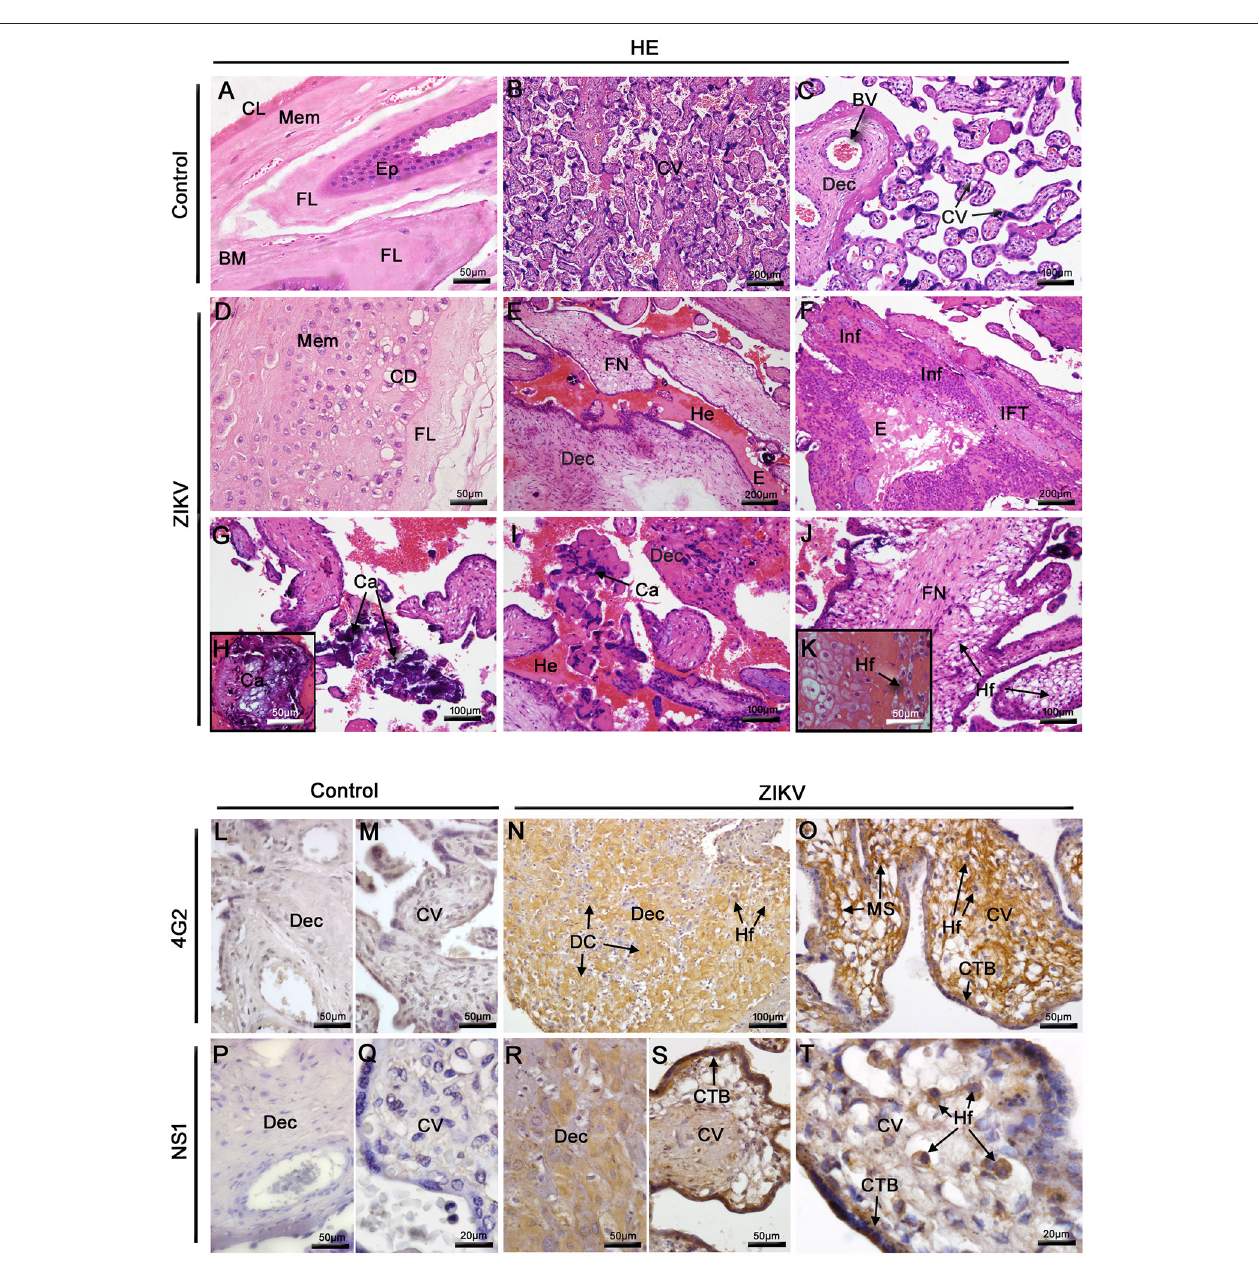
FIGURE 1 | Histopathological analysis of the placenta and detection of ZIKV. (A–C) Placenta of a non-ZIKV patient stained with H.E. and presenting normal features: membrane (Mem), (MB) basal membrane, (FL) fibroblastic layer, (CL) compact layer, (Ep) epithelium, chorionic villi (CV), maternal decidua (Dec), and blood vessels (BV). (D–K) Sections of ZIKV-infected placental tissue stained with H.E., showing abnormalities in membrane, with cellular degeneration (CD), in the decidua and chorionic villi, including fibrinoid necrosis (FN), hemorrhage (He), mononuclear inflammatory infiltrate (Inf), infarct (IFT), calcification (Ca) and Hofbauer cells with clear cytoplasm (Hf). (L,M,P,Q) The flavivirus E protein and NS1 antigens of ZIKV were not detected by immunohistochemistry in the control placenta. (N–O) Detection of ZIKV E protein in decidual cells (DC), cytotrophoblasts (CTB), mesenchymal cells (MS) and Hofbauer cells (Hf) of the infected placenta. (R–T) The NS1 protein of ZIKV was also detected by immunohistochemistry in decidual cells (DC), cytotrophoblasts (CTB) and Hofbauer cells (Hf).